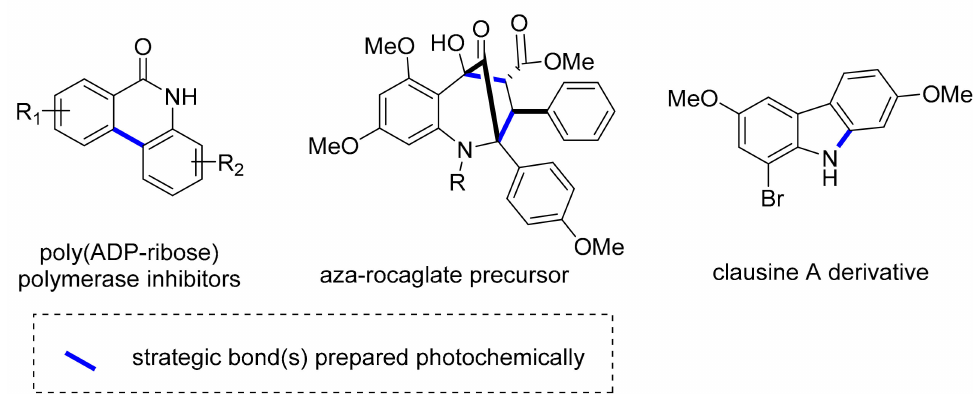
Figure 9. Structures of poly(ADP-ribose) polymerase inhibitors and natural product analogues prepared in